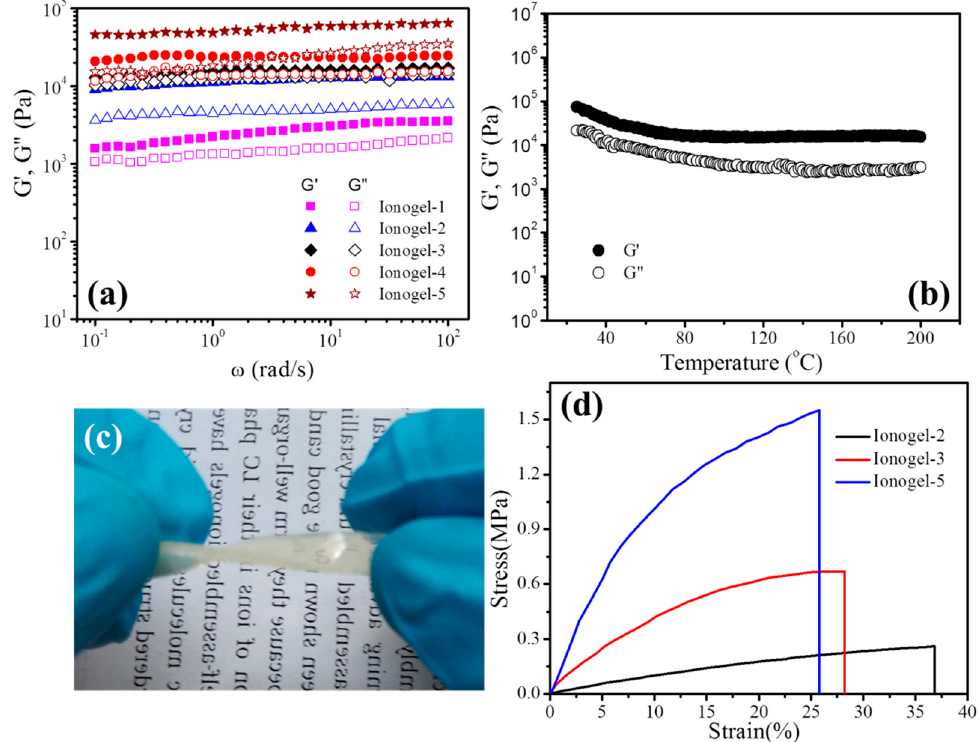
Figure 3. ( a ) Changes of G ′ and G ′′ as a function of ω at 25 °C for ionogels; ( b ) changes of G ′ and G ′ with increasing temperature at an angular frequency of 6.28 rad/s for ionoge-5; ( c ) twisted rectangular shape ionogel; ( d ) stress-strain curves of ionogels with different content of HP-A.